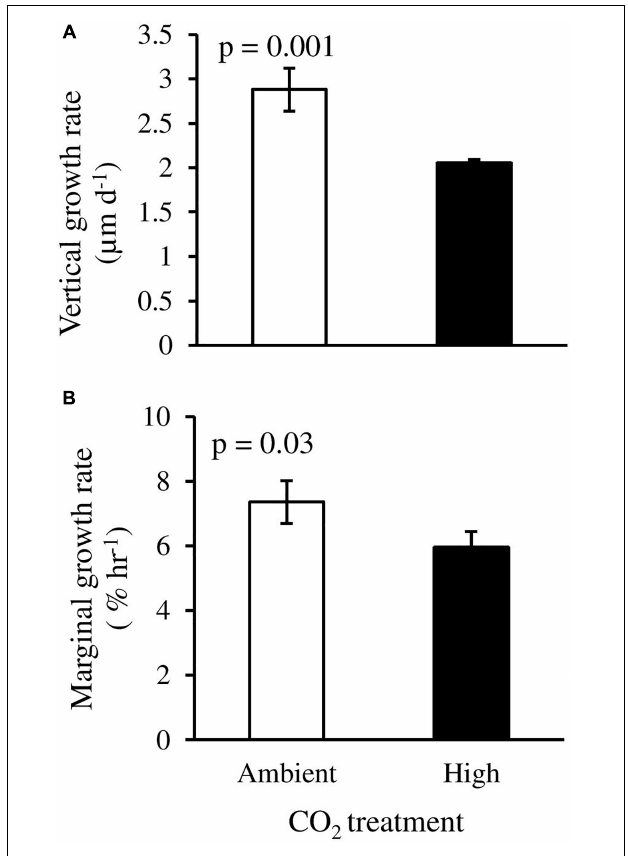
FIGURE 6 | Effects of elevated CO 2 on (A) vertical growth rate, and (B) marginal growth rate of CCA recruits in response to two treatments: ambient CO 2 (CO 2 between 400.8 and 448.1 µ atm, pH 8.0–8.03) and high CO 2 (CO 2 between 998.9 and 1070.6 µ atm, pH 7.67–7.70). Columns with error bars represent means ± SE [ (A) : n = 3 for ambient CO 2 and n = 2 for high CO 2 ; (B) n = 6, biological replicates].